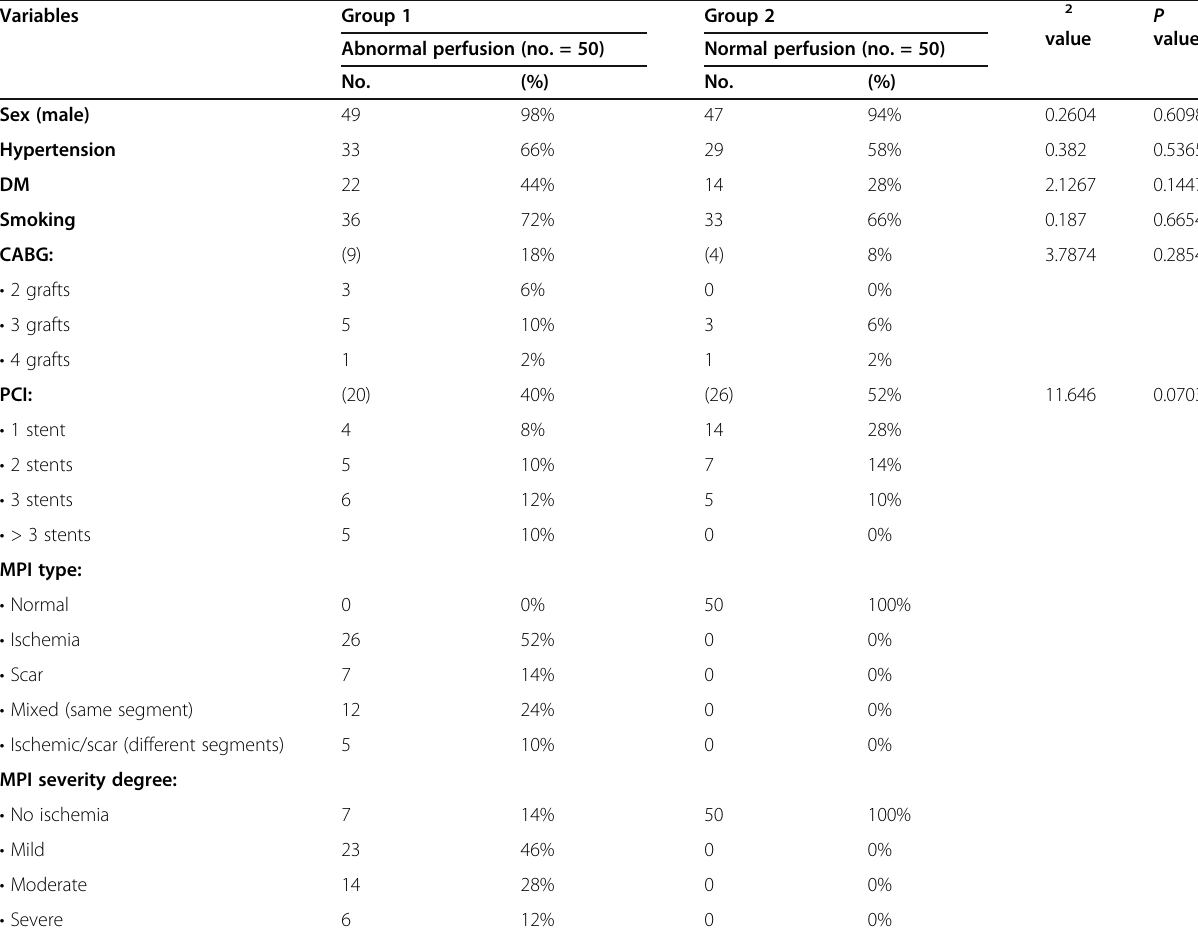
Table 1 The demographic data and risk factors in both